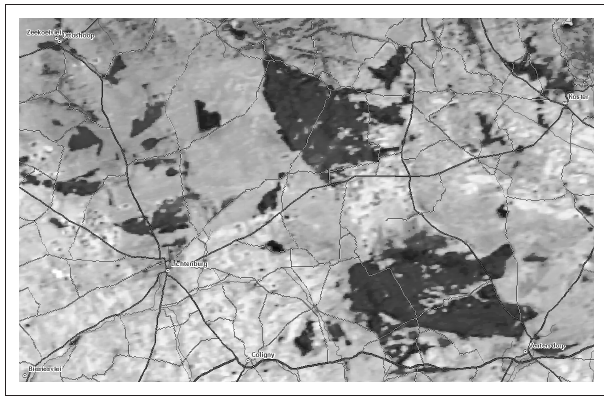
FIGURE 4: Greyscale representation of a MODIS satellite image (.tiff file).